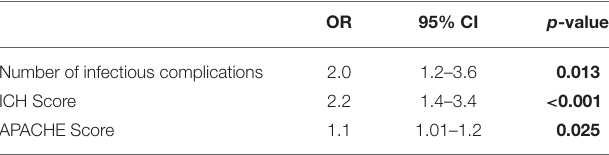
TABLE 3 | Risk factors for poor functional outcome (mRS > 2) evaluated in 229 ICH patients. OR 95% CI p -value Number of infectious complications 2.0 1.2–3.6